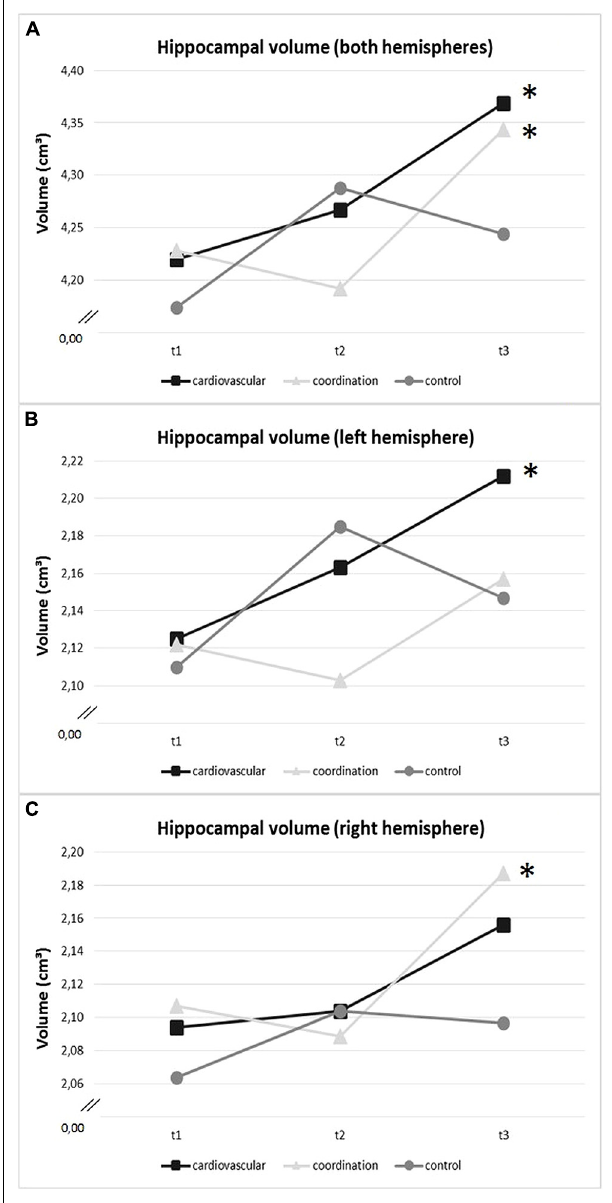
FIGURE 4 | Change in volume of (A) hippocampal volume of both hemispheres, (B) left hippocampus, and (C) right hippocampus (in cm 3 ) within training groups (cardiovascular training, coordination training, control group) over the intervention period ( t 1: baseline, t 2: after 6 months, t 3: after 12 months). *Significant change ( p < 0.05).